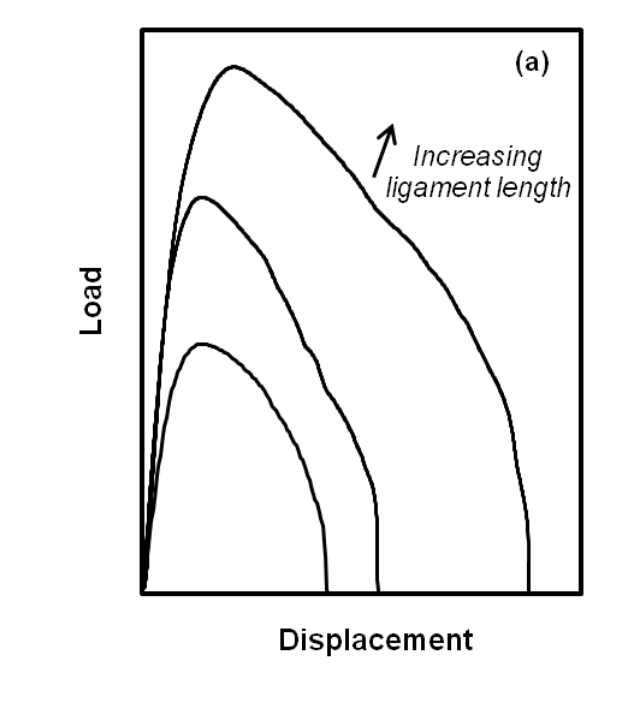
Figure 14. Determination of EWF parameters ( w with increasing ligament